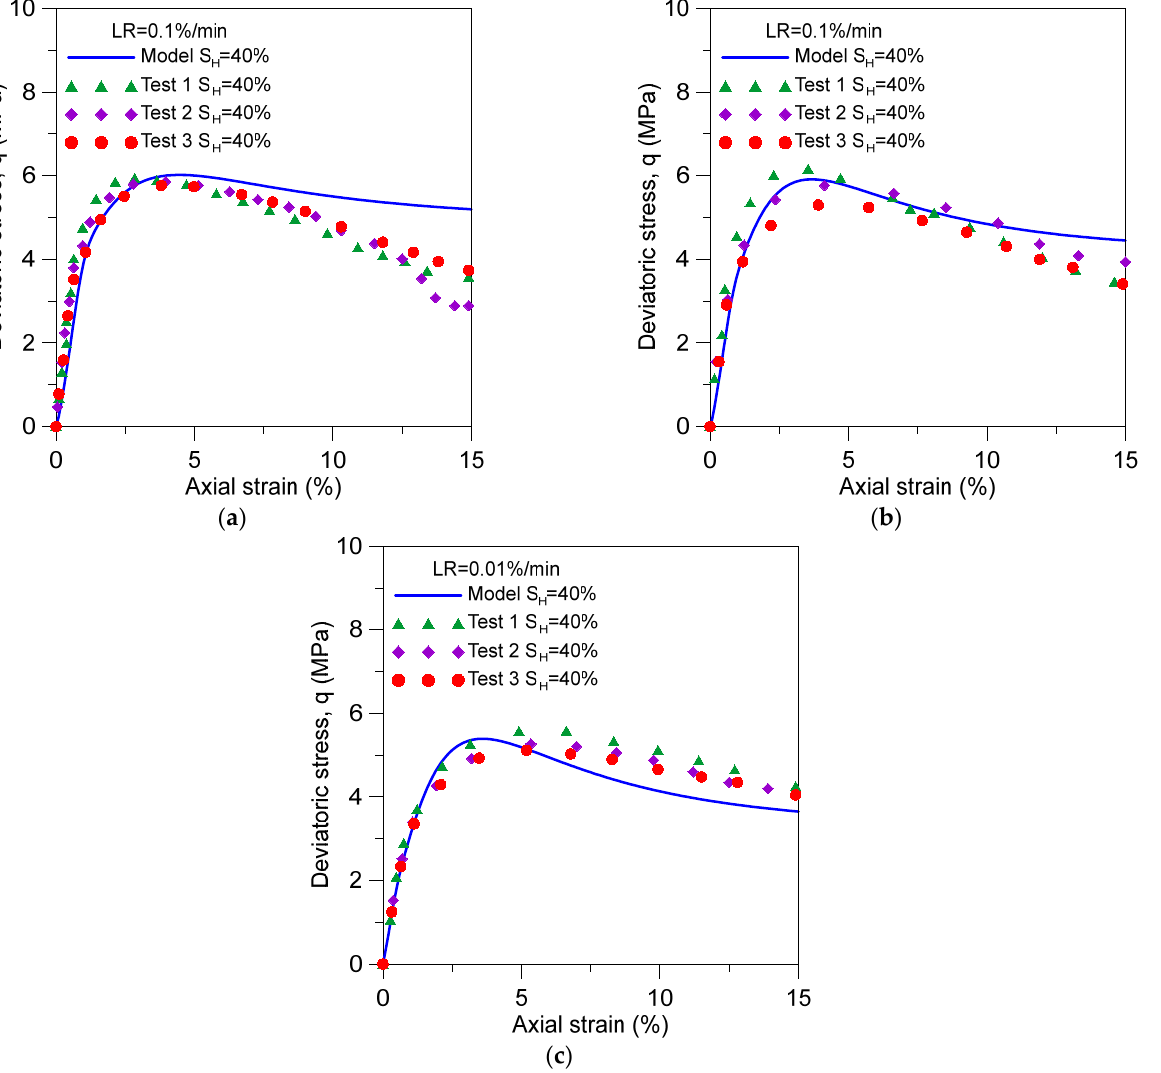
Figure 12. Modeling the tests reported in Miyazaki et al. [33]. ( a ) Constant loading rate LR = 0.1%/min; ( b ) constant LR = 0.1%/min; and ( c ) constant LR =